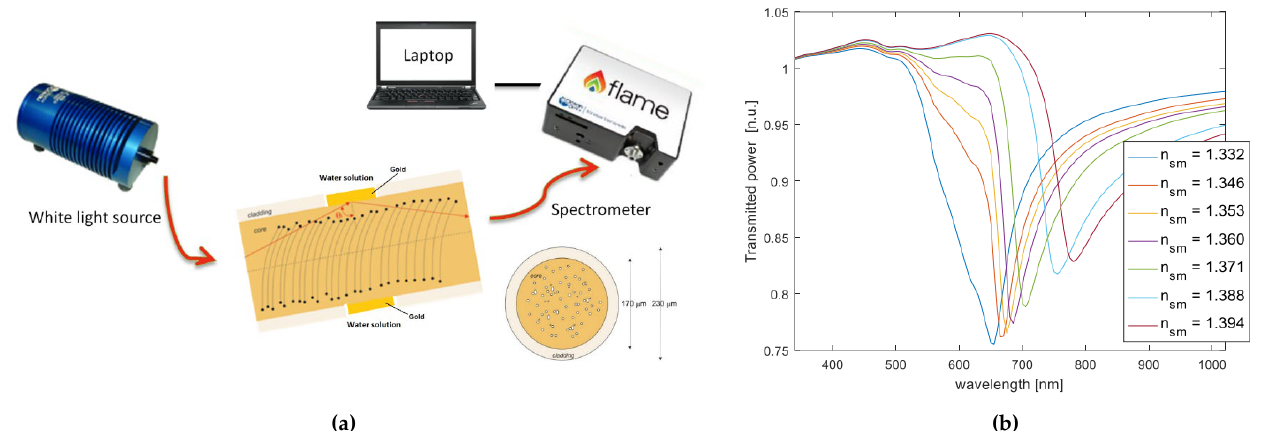
Figure 9. Silica LDF-based SPR sensor system: ( a ) data acquisition and working scheme; ( b ) SPR spectra obtained at different refractive indices from 1.332 to 1.394. Image reproduced from [70].